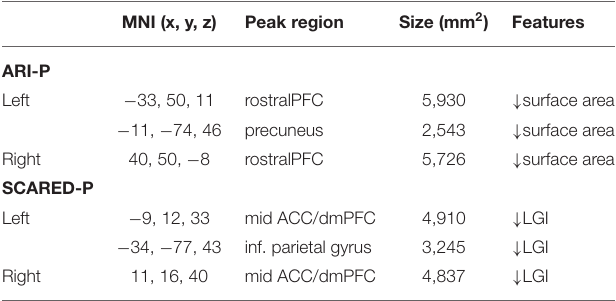
TABLE 2 | Main results; ARI-P, Affective Reactivity Index, Parents’ report; SCARED-P, Screen for Child Anxiety Related Emotional Disorders, Parent’s report; MNI, Montreal Neuroimaging Institute; LGI, Local Gyrification